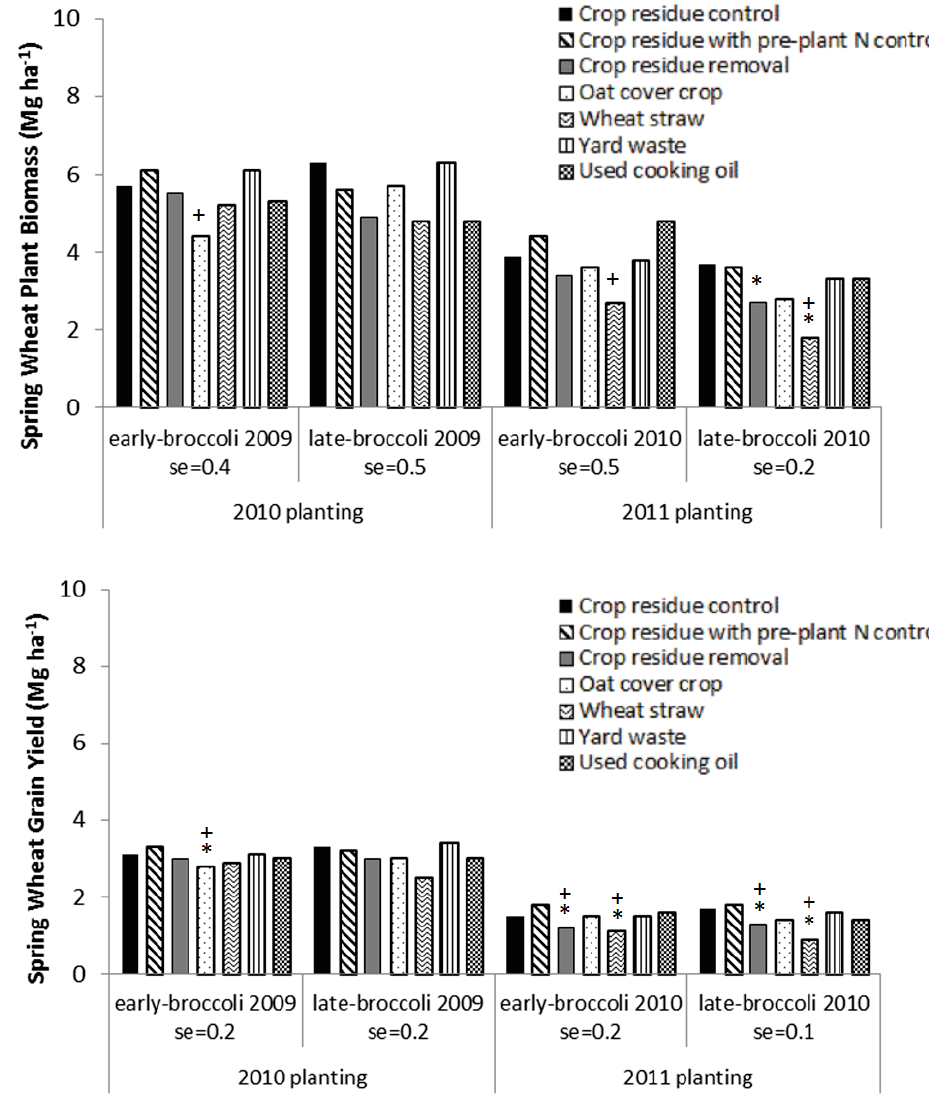
Figure 3. The spring wheat plant biomass (grain + straw) and grain yield (Mg ha (cid:237)(cid:20) ) in 2010 and 2011, as affected by the previous years’ treatments in the early- and late-broccoli systems. Symbols denote a significant difference ( P < 0.05) compared to the crop residue control * or the crop residue with pre-plant N control +, based on a multiple means comparison with a Dunnett-Hsu adjustment. The se values represent the standard error of the